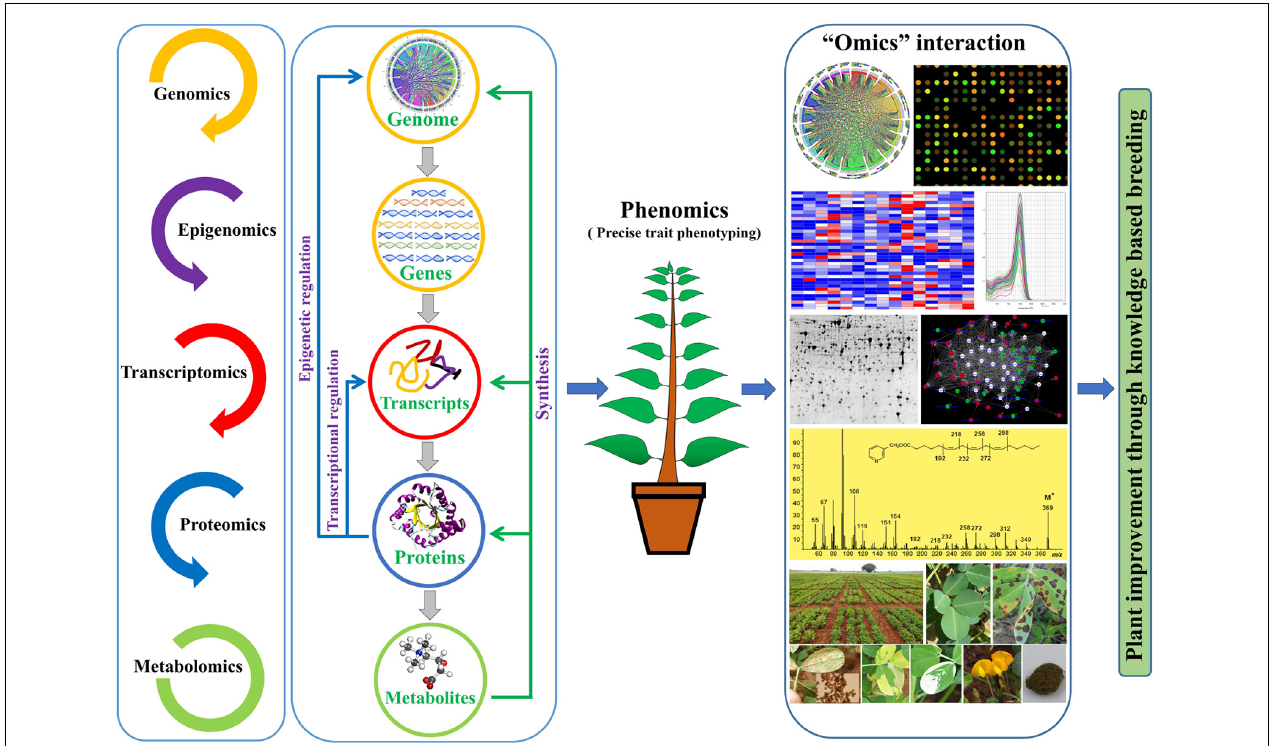
FIGURE 2 | An overview for the use of ‘omics’ approaches for crop